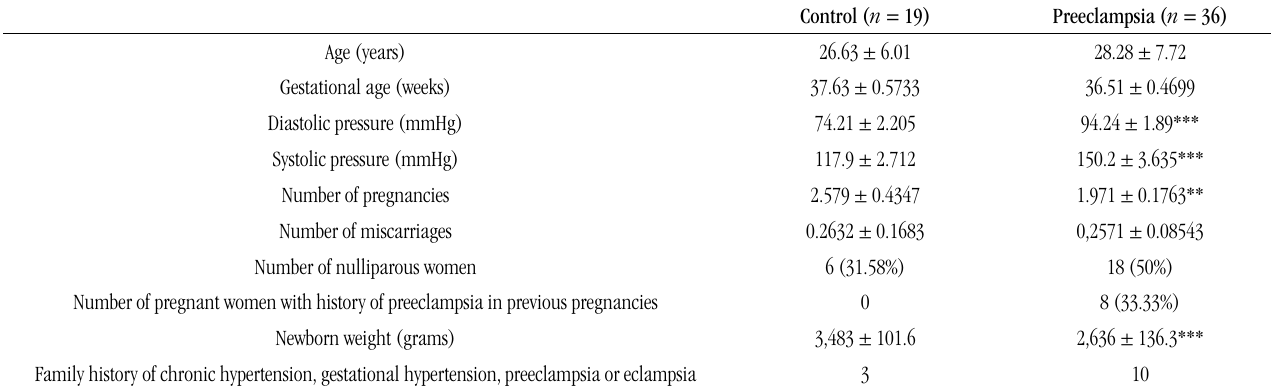
taBLE − Clinical characteristics of the studied pregnant women and relevant factors related to preeclampsia. Results are expressed in mean ±